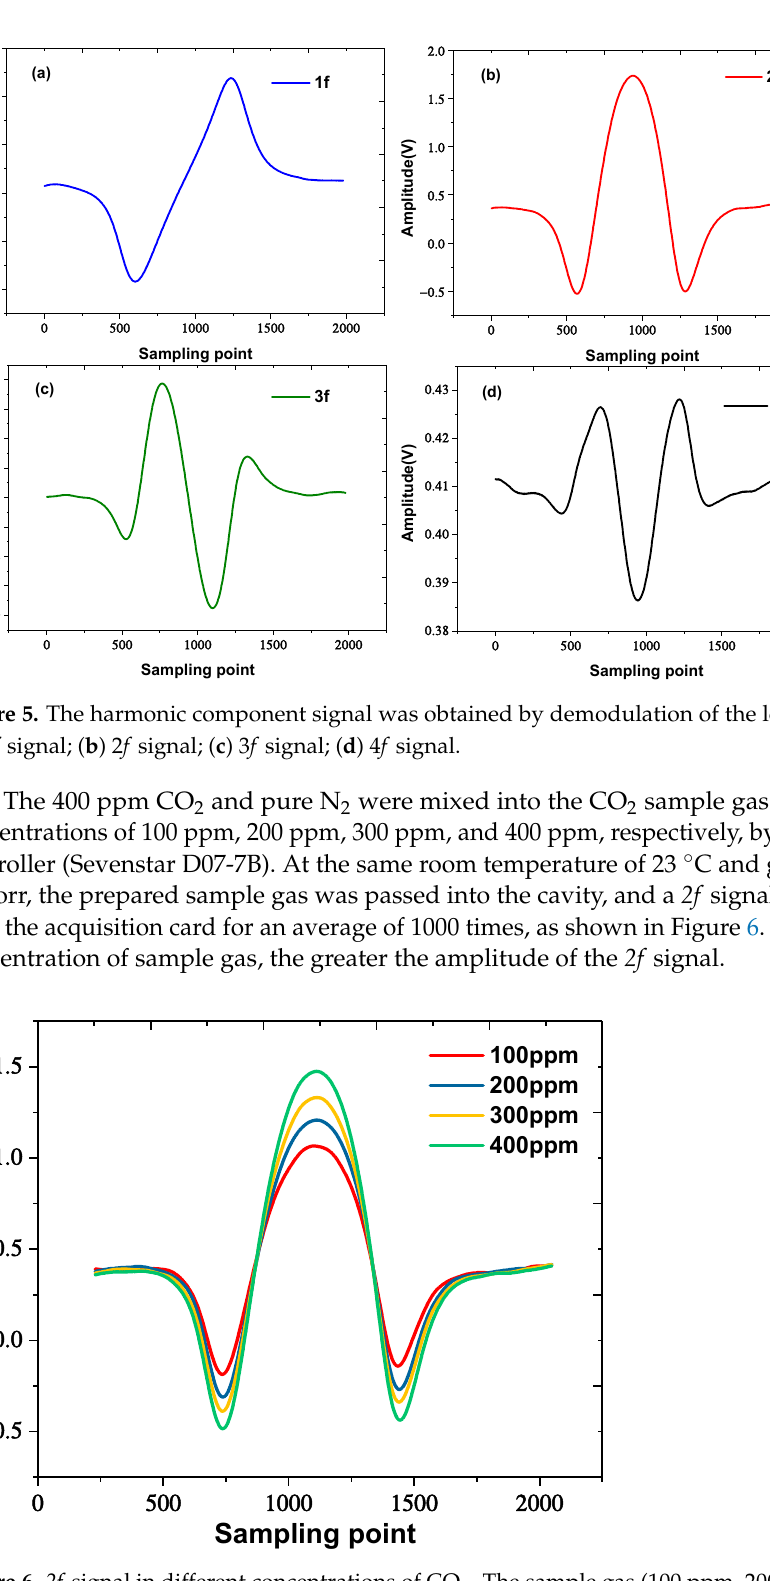
Figure 6. 2f signal in different concentrations of CO 2 . The sample gas (100 ppm, 200 ppm, 300 ppm, 400 ppm) prepared was successfully passed into the cavity to obtain a 2f signal at a room temperature of 23 °C and a gas pressure of 90 Torr.